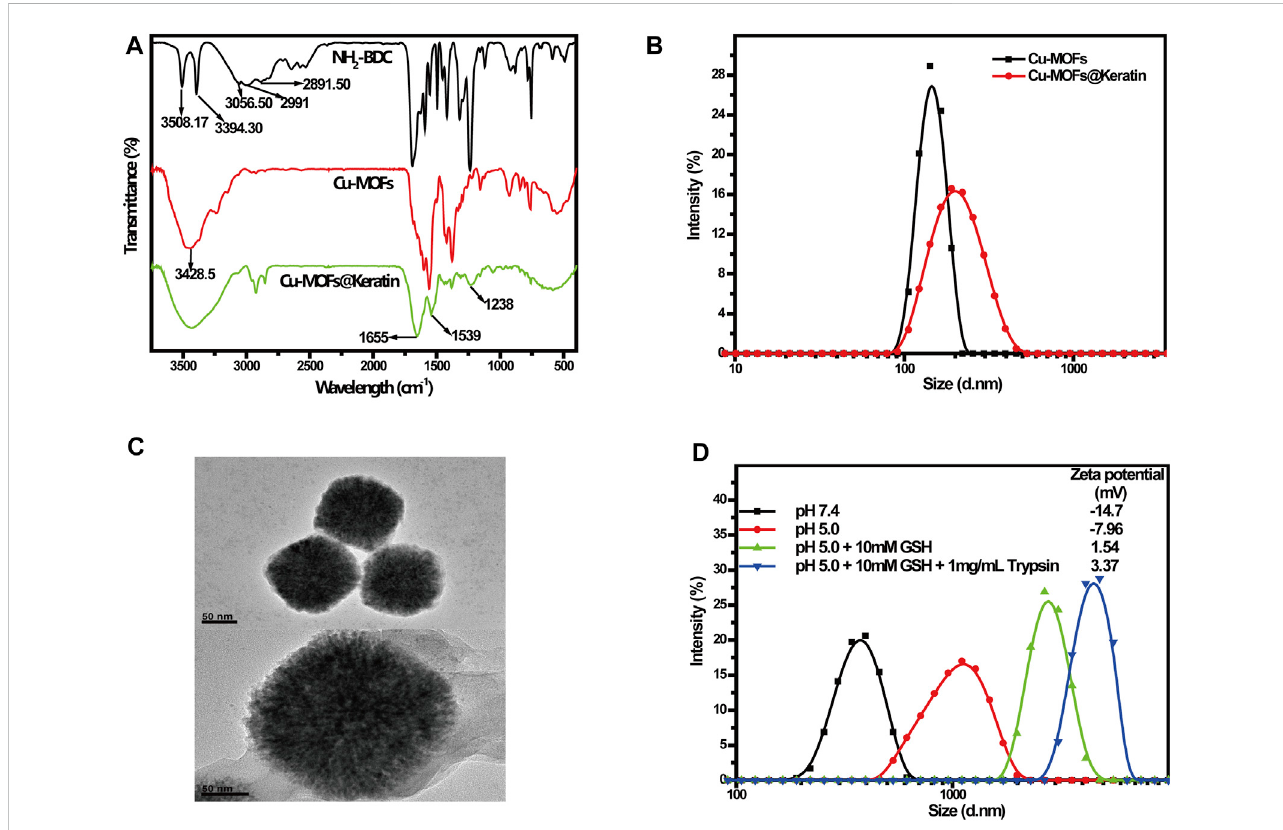
FIGURE 2 (A) FT-IR spectra of NH 2 -BDC, Cu-MOFs and Cu-MOFs@Keratin; (B) Particle size distribution of Cu-MOFs and Cu-MOFs@Keratin; (C) TEM of Cu-MOFs (top) and Cu-MOFs@Keratin (bottom); (D) Particle size distribution and Zeta potential of Cu-MOFs@Keratin in different simulation